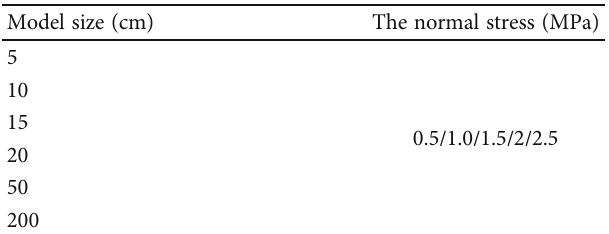
Table 3: The test